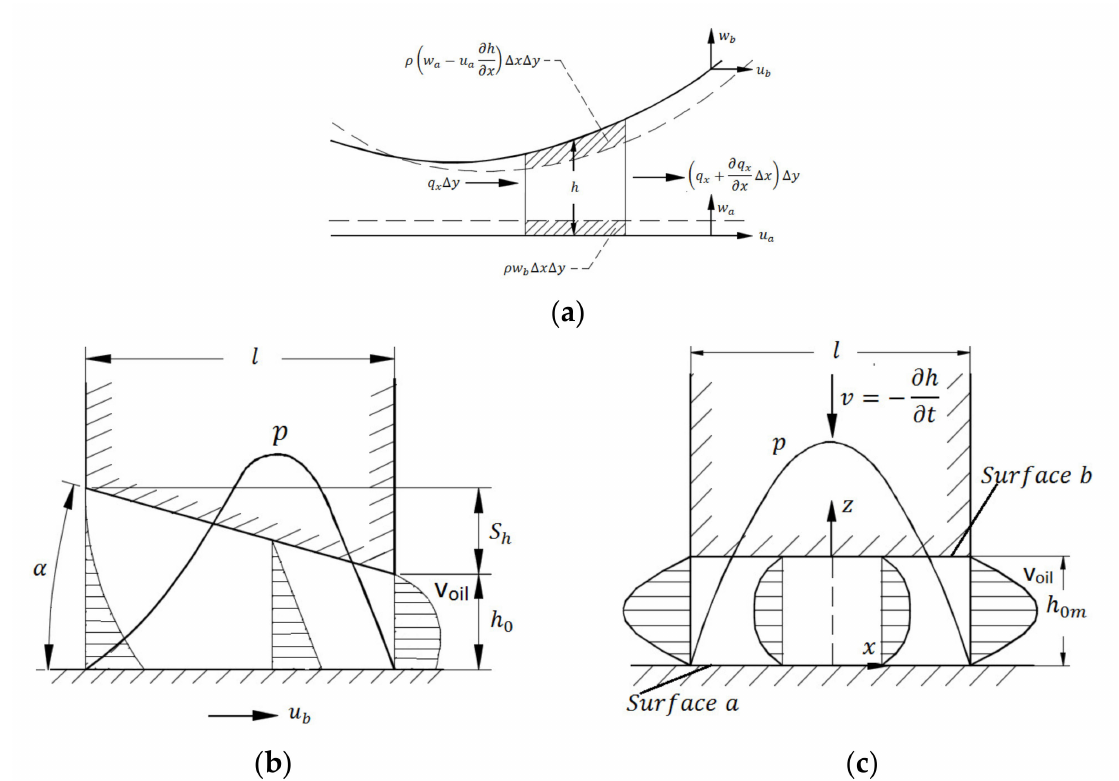
Figure 4. ( a ) Mass flow through a rectangular section; ( b ) fixed-incline slider bearing; and ( c ) parallel-surface squeeze film